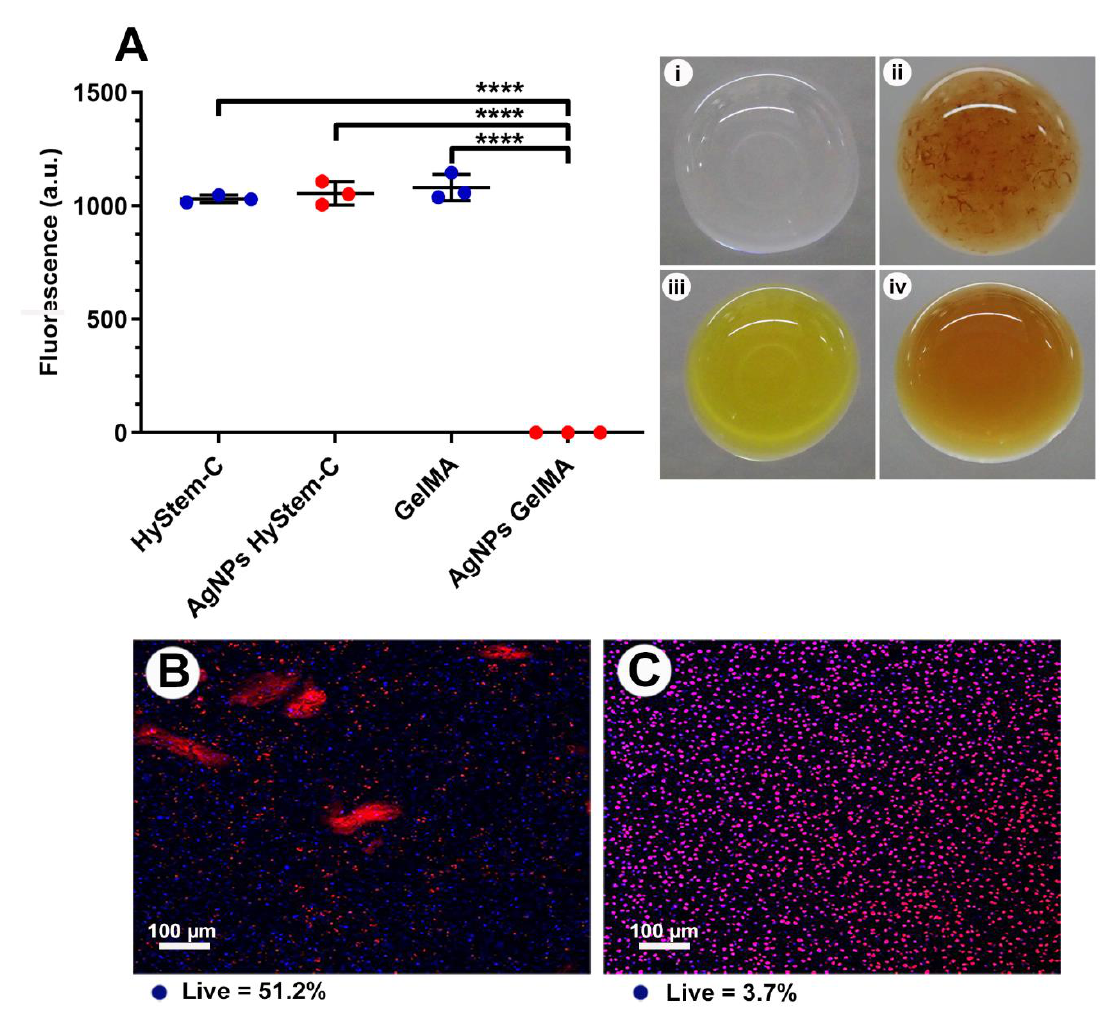
Figure 3. ( A ) Graph showing cell viability of HGFs encapsulated with 200 µg/mL AgNPs (toxic concentration), and controls. **** = p < 0.0001. Right, photographs of the two hydrogel systems; ( i ) HyStem ® -C, ( ii ) HyStem ® -C with AgNPs, ( iii ) GelMA, ( iv ) GelMA with AgNPs. Images in iii and iv were taken upon addition of AgNPs prior to cross-linking, aggregation of AgNPs in HyStem ® -C but not GelMA can be seen. Confocal images of live/dead cells are shown in ( B ) HyStem ® -C stiff and ( C ) GelMA standard containing 200 µg/mL AgNPs; live cells — blue, dead cells — red.